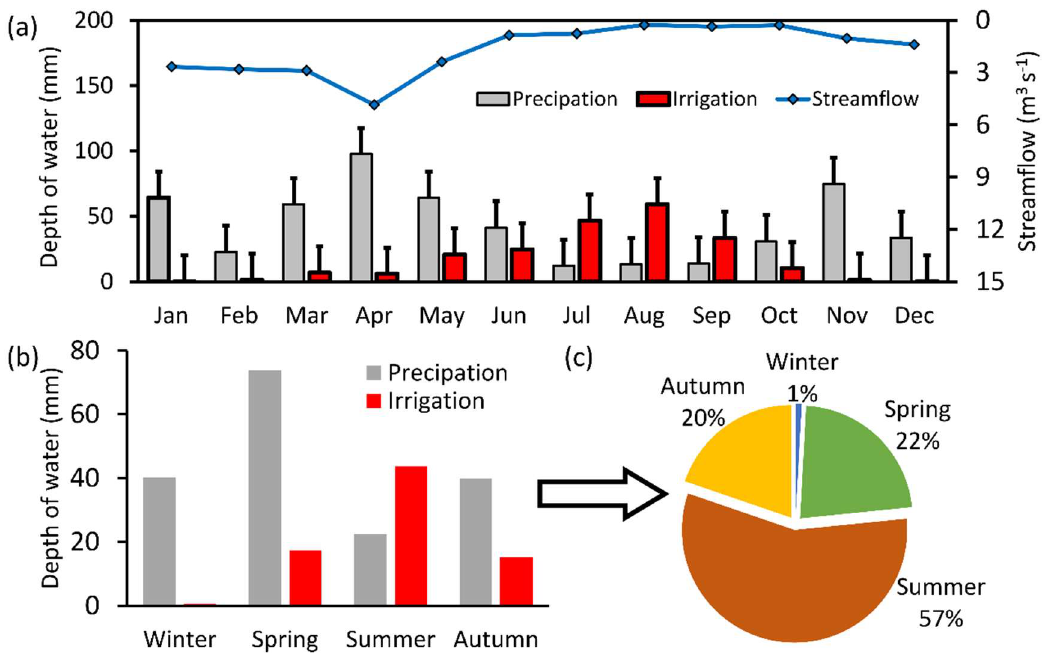
Figure 4. ( a ) Monthly average precipitation, irrigation, and streamflow distribution at the watershed outlet in Traibuenas from mid-2017 to 2020, ( b ) seasonal precipitation and irrigation distribution pattern, and ( c ) the percentage of irrigation water applied each season.